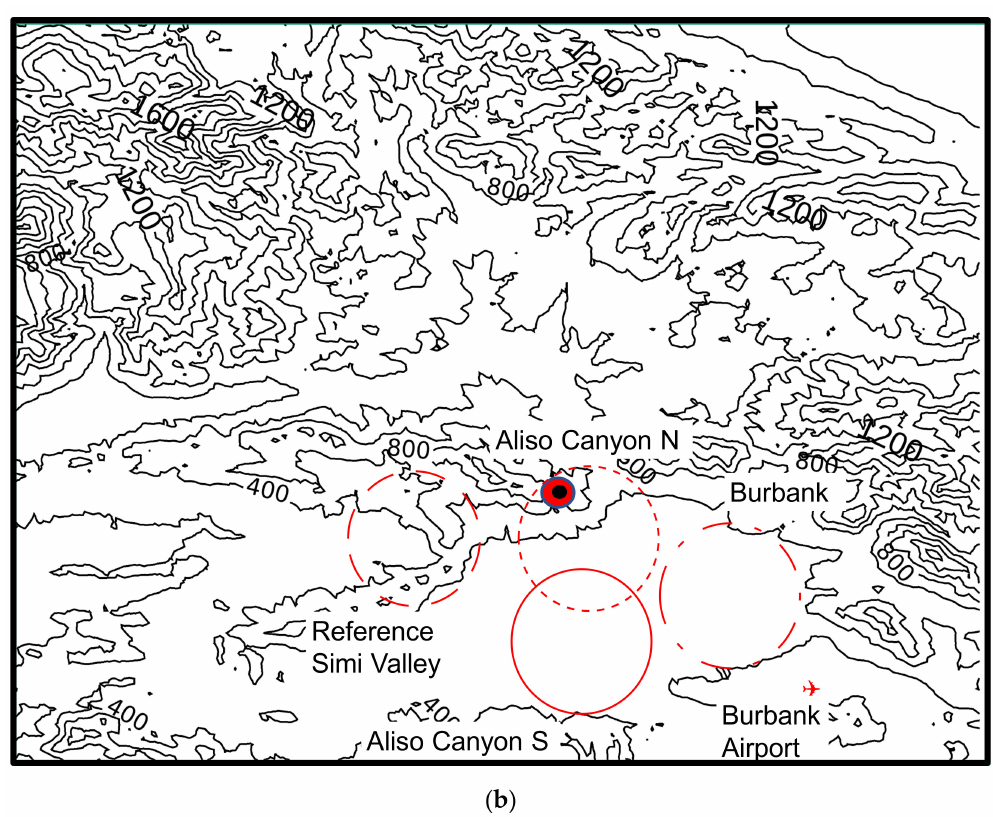
Figure 1. ( a ) Aliso Canyon location; and ( b ) geometric relationship between the leak point and the Greenhouse gases Observing SATellite (GOSAT) footprints (circles) in Simi Valley (dashed line), Aliso Canyon-N (dotted line), Aliso Canyon-S (bold line), and Burbank (dash-dotted